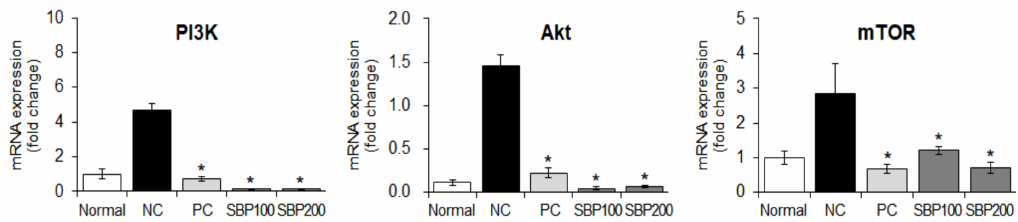
Figure 10. Effects of SBP extract on the mRNA expression of PI3K/mTOR signaling factors in OVA/Alum − sensitized mice liver tissue. Data are expressed as mean ± SEM. Significantly different from the NC group (* p < 0.05). SBP, sword bean pod; NC, negative control; PC, positive